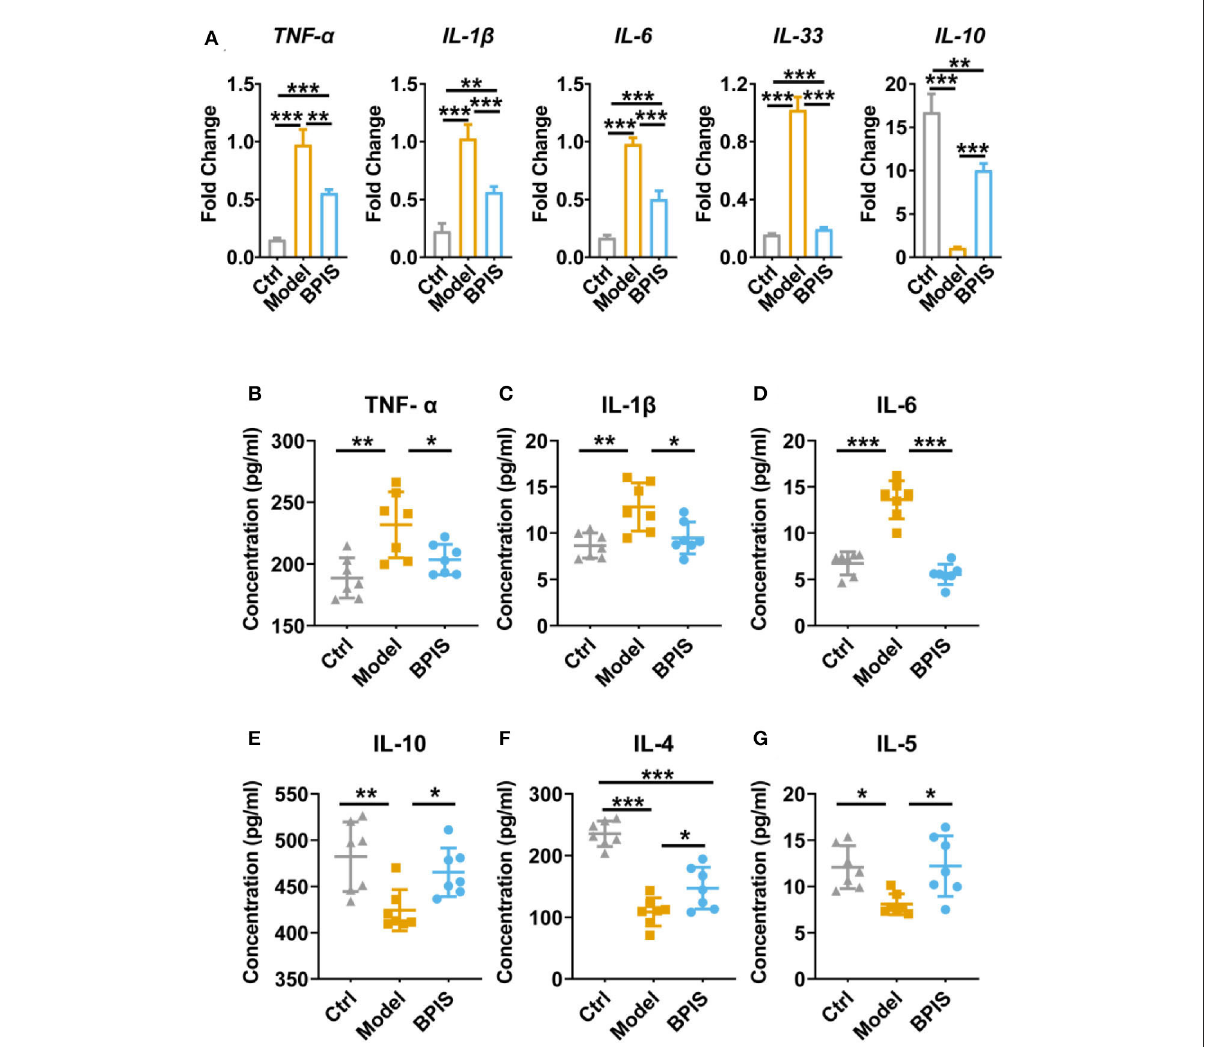
FIGURE2 BPIS suppressed inflammatory cytokines in vivo . (A) mRNA expressions of inflammatory cytokines including Tnf- α , Il-1 β , Il-6, Il-33, and Il-10 in colon tissues. (B–G) Concentrations of the cytokines TNF- α (B) , IL-6 (C) , and IL-1 β (D) ; Treg-type cytokine IL-10 (E) , and Th2-type cytokines IL-4 (F) and IL-5 (G) were determined by ELISA kit. Data are presented as the means ± SD ( n ≥ 5) and were analyzed by an ordinary one-way ANOVA with Tukey’s multiple comparisons. * p < 0.05, ** p < 0.01, *** p <